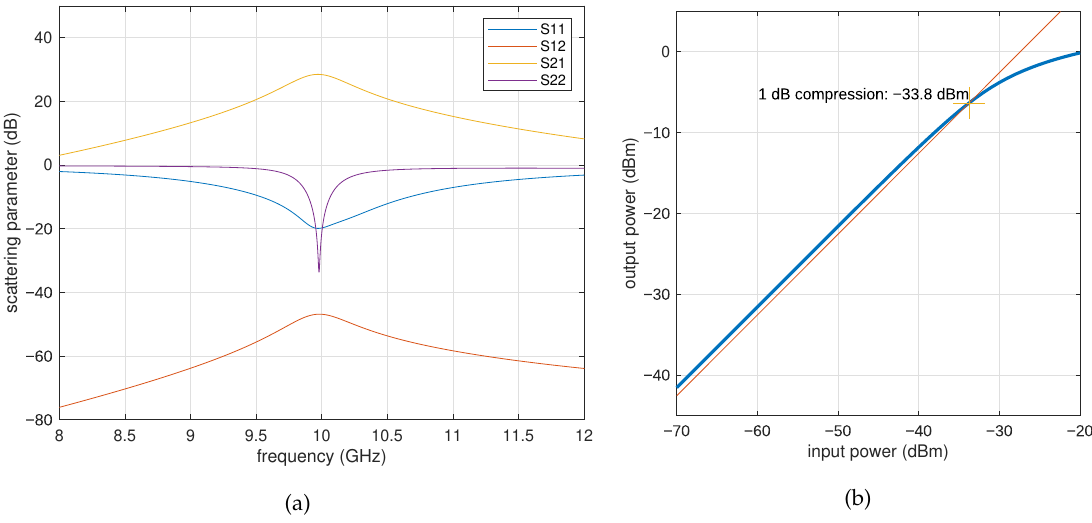
Figure 11. Simulations of the LNA input–output scattering parameters ( a ) and input-referred 1-dB compression point ( b ).